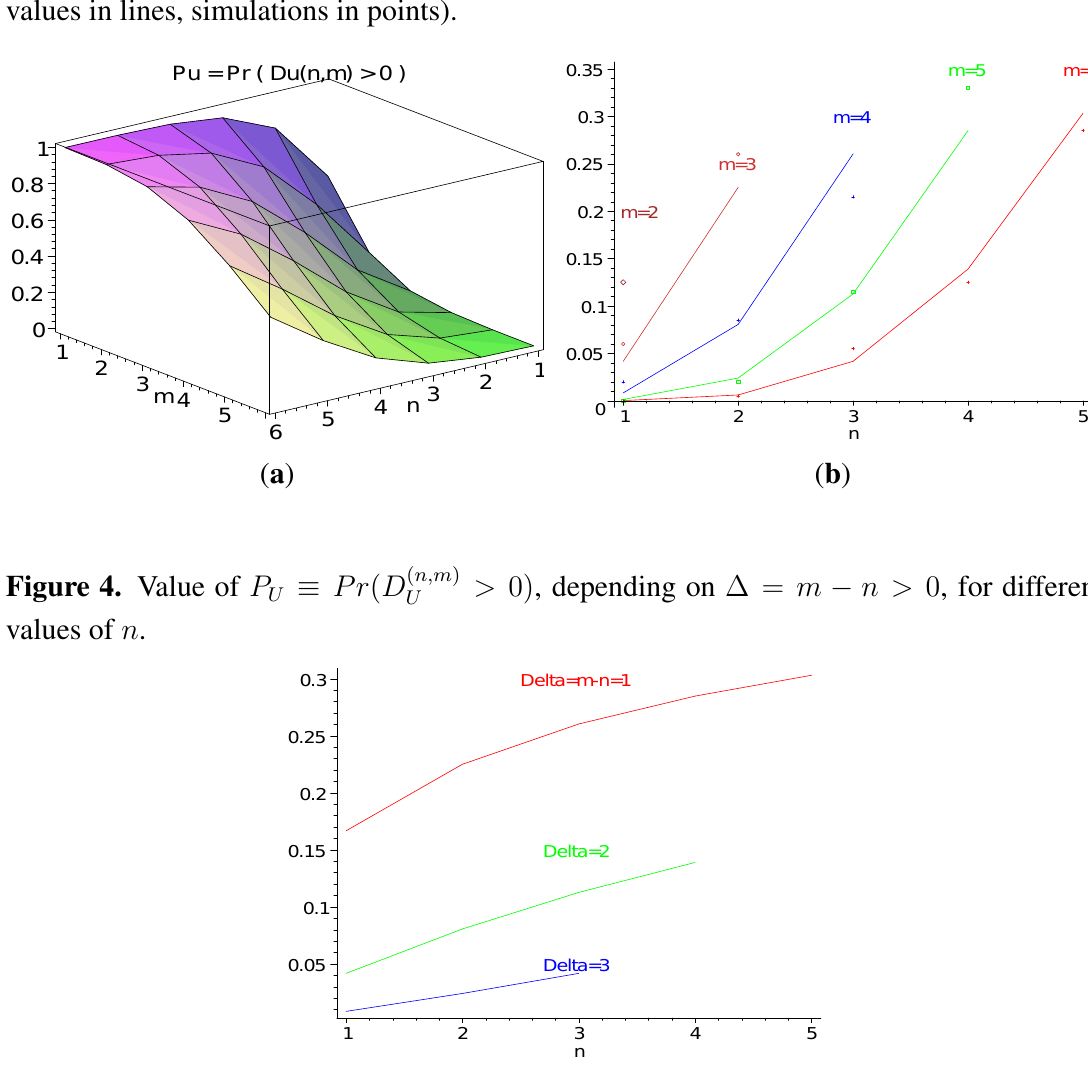
≡ P r ( D ( n,m ) > 0) , . ( a ) Theoretical value of P U U U for m = 1 , 2 , 3 , 4 , 5 , n < m (theoretical U